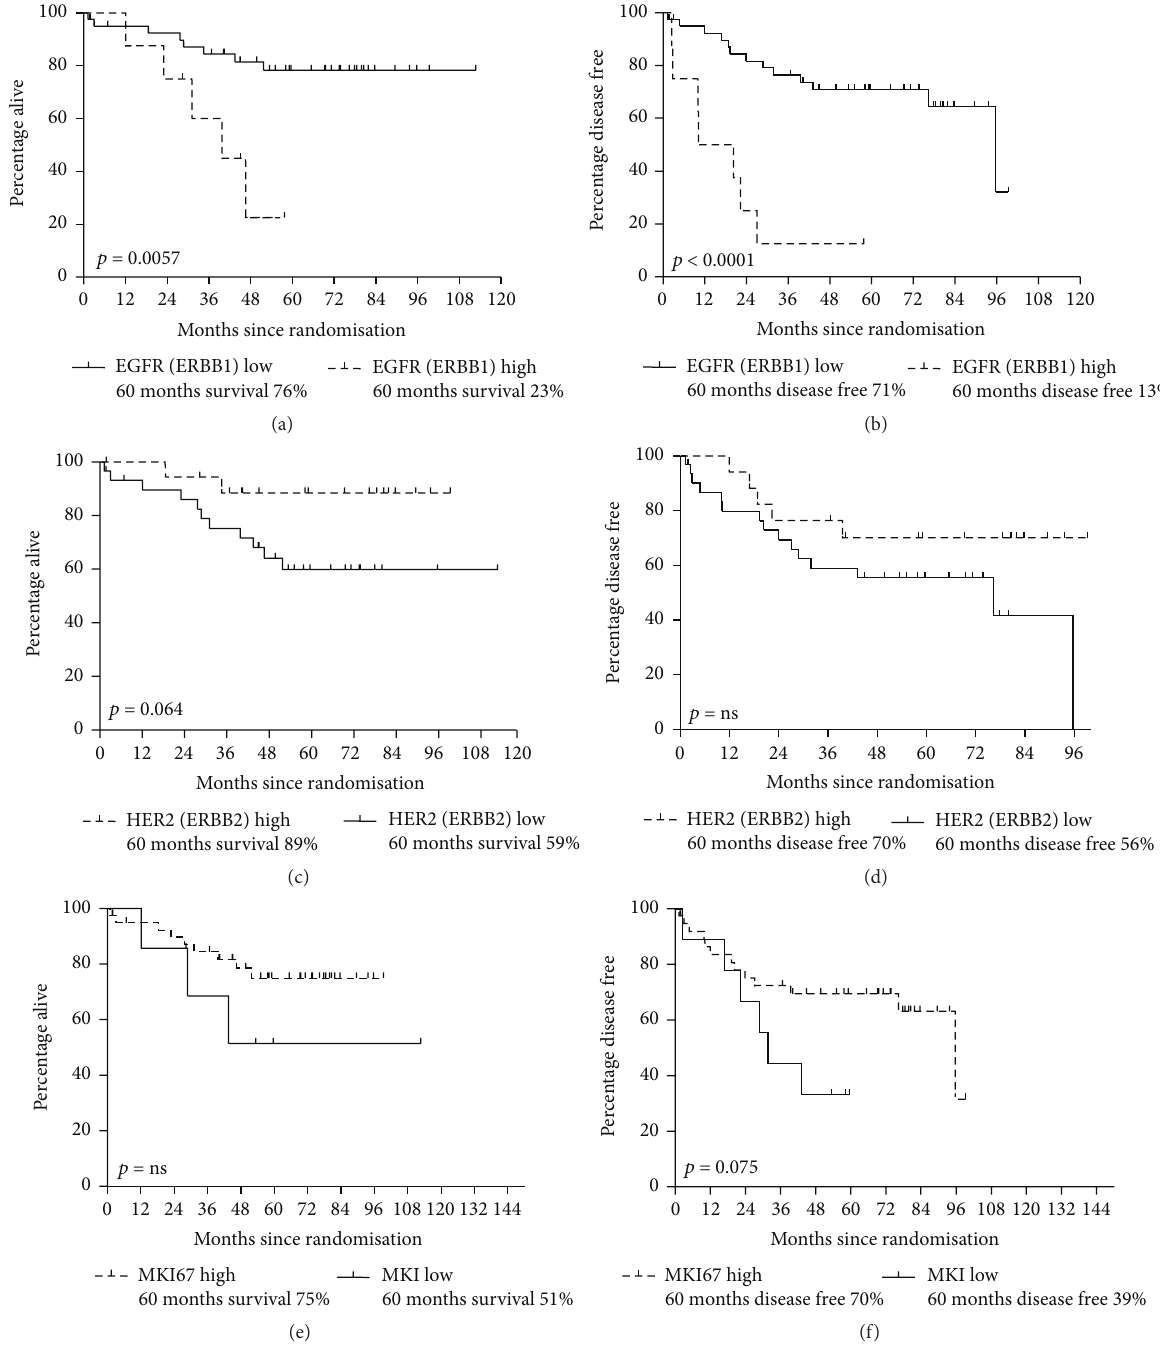
Figure 3: (a) Kaplan-Meier curve for overall survival (OS) according to the mRNA status of EGFR (ERBB1) . The predictive values for EGFR (ERBB1) high and low expression were estimated using the partitioning test. Five-year overall survival for low EGFR (ERBB1) expression was 76%, for high EGFR expression 60%; 𝑝 = 0.0057 . (b) Kaplan-Meier curve for disease-free survival (DFS) according to the mRNA status of EGFR (ERBB1) . The predictive values for EGFR (ERBB1) high and low expression were estimated using the partitioning test. Five-year disease-free survival for low EGFR (ERBB1) expression was 71%, for high EGFR (ERBB1) expression 13%; 𝑝 < 0.0001 . (c) Kaplan-Meier curve for overall survival (OS) according to the mRNA status of ERBB2 (HER2). The predictive values for ERBB2 (HER2) high and low expression were estimated using the partitioning test. Five-year overall survival for low HER2 (ERBB2) expression was 59%, for high HER2 (ERBB2) expression 89%; 𝑝 = 0.064 . (d) Kaplan-Meier curve for disease-free survival (DFS) according to the mRNA status of ERBB2 (HER2). The predictive values for ERBB2 (HER2) high and low expression were estimated using the partitioning test. Five-year overall survival for low HER2 (ERBB2) expression was 56%, for high HER2 (ERBB2) expression 70%; 𝑝 = n . s. (e) Kaplan-Meier curve for overall survival (OS) according to the mRNA status of MKI67 . The predictive values for MKI67 high and low expression were estimated using the partitioning test. Five-year overall survival for low MKI67 expression was 75%, for high MKI67 expression 55%; 𝑝 = n . s. (f) Kaplan-Meier curve for disease- free survival (DFS) according to the mRNA status of MKI67 . The predictive values for MKI67 high and low expression were estimated using the partitioning test. Five-year overall survival for low MKI67 expression was 39%, for high MKi67 expression 70%; 𝑝 = 0.075